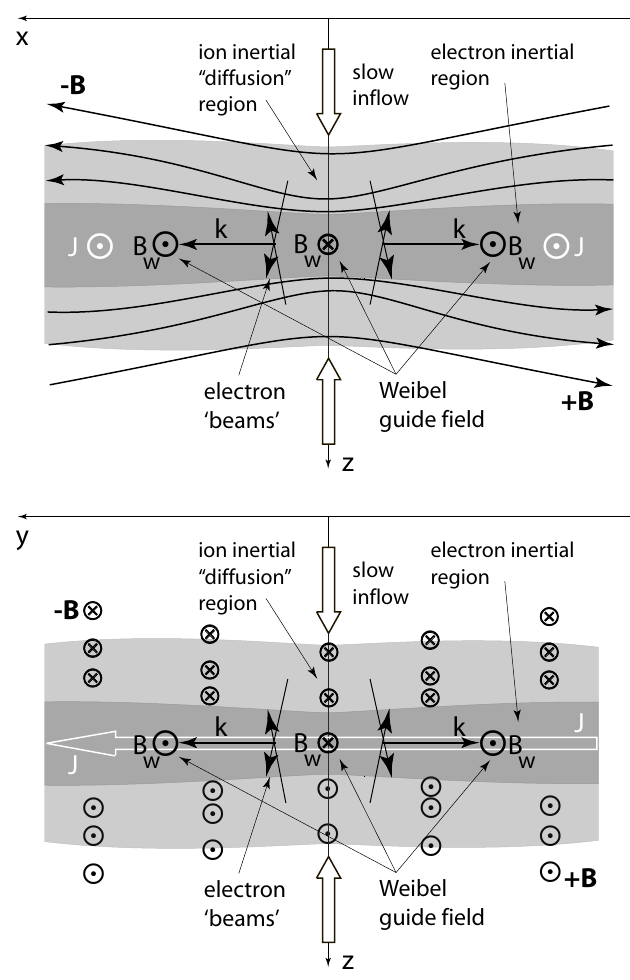
Fig. 2. Conditions inside a local electron inertial region. Inside the inertial region the electron components form two oblique beams which become smeared out by the two-stream instability. The re- sulting thermal-anisotropic Weibel instability generates a magnetic vortex of field b W with wavenumber k ⊥ V b perpendicular to the beam configuration. These vortices close in the current plane (x,y) . The sense of the magnetic vortices alternates along the current di- rection. Shown is the part of the lowest order vortex where the field is along the sheet current J . At a phase of π/ 2 along the current the Weibel fields point along the ambient magnetic field causing wobbling of the current